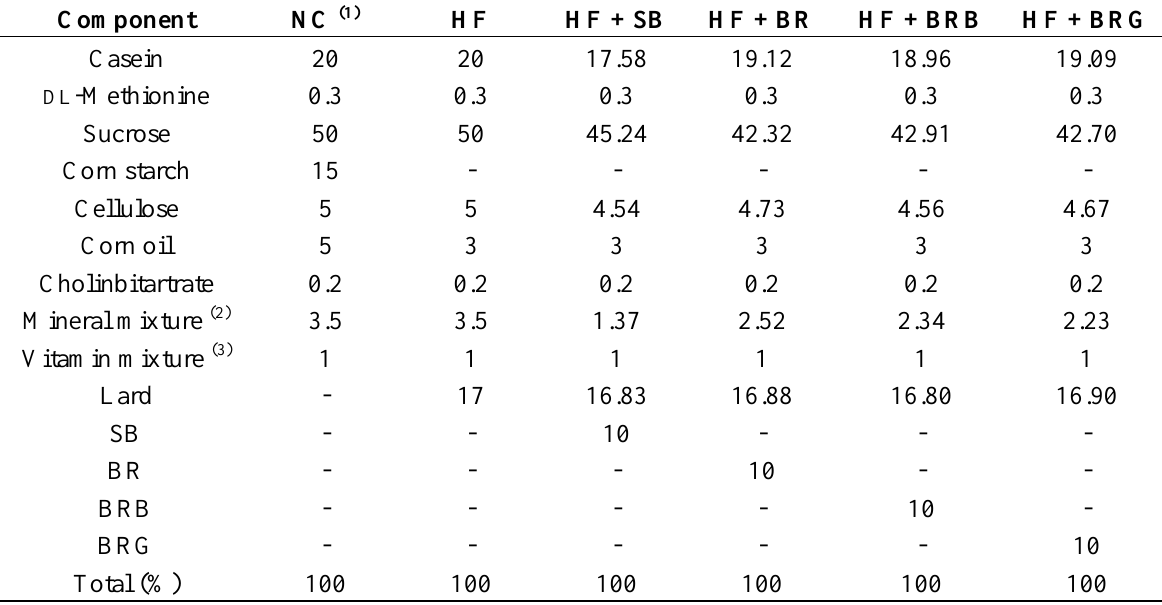
Table 2. Composition of the experimental diets (%